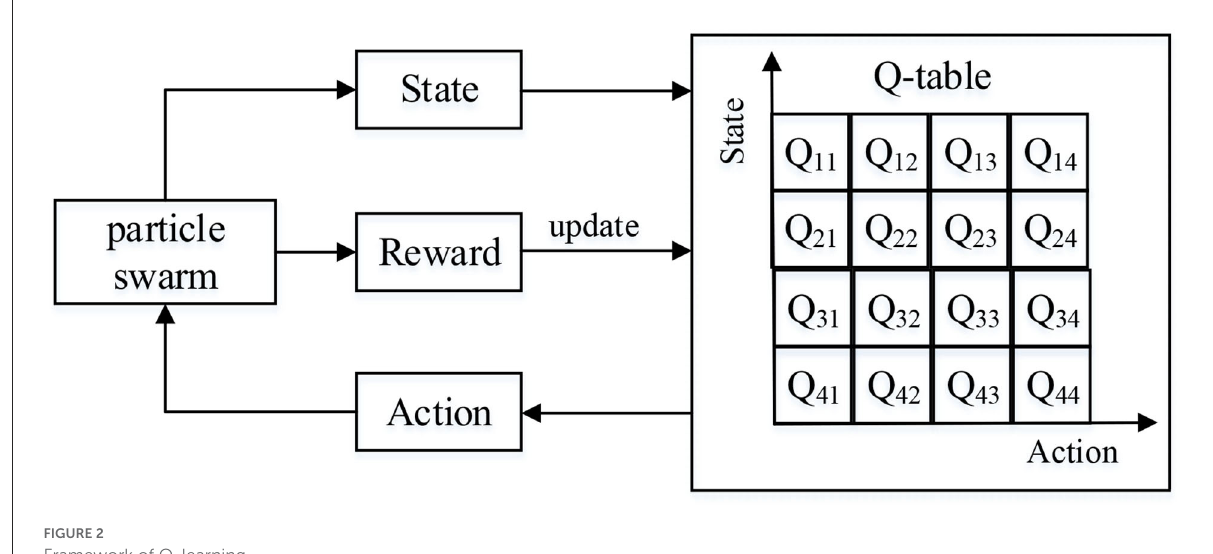
FIGURE2 Framework of